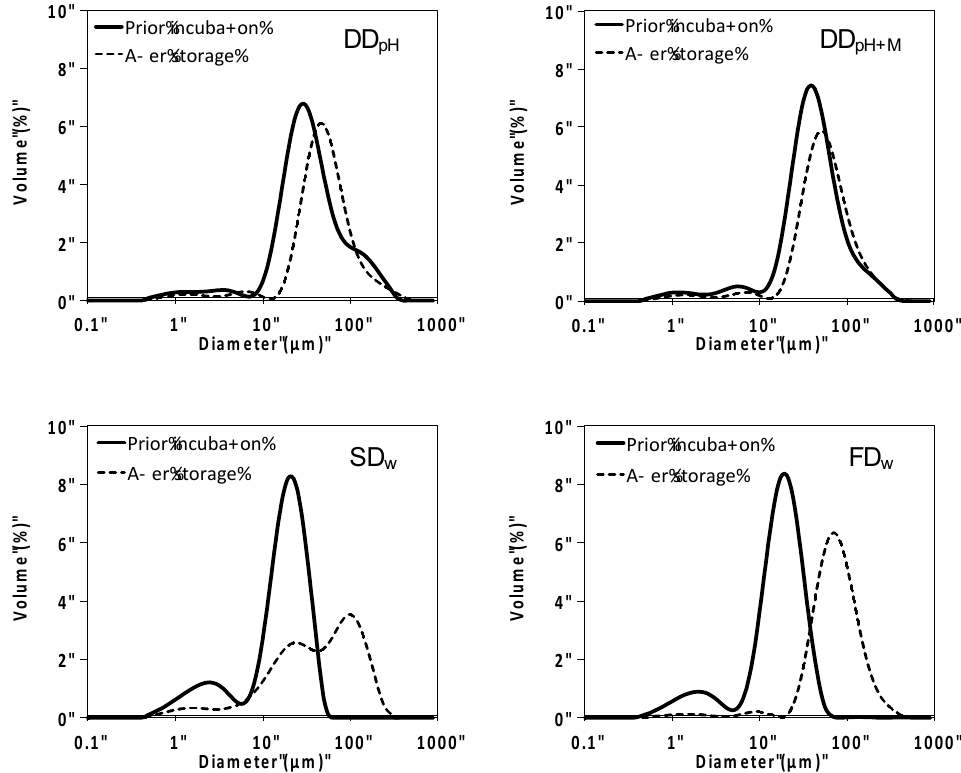
Figure 6. Particle size distribution of oil-in-water emulsions stabilized by thylakoid powder produced in different ways prior incubation and after 8 months storage in 61 RH%. DD pH = drum-dried powder produced by the pH method, DD pH + M = drum-dried powder produced by the pH method with addition of maltodextrin, SD w = spray-dried powder produced by the water method, FD w = freeze-dried powder produced by the water method.